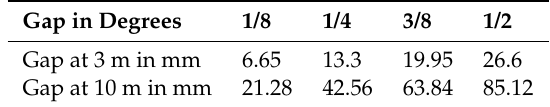
Figure 10. Angular resolution summary results: mean range using 10,000 sample sweeps stepping up to a gap of 1/2 ◦ . Table 4. Gap distance in millimeters as the angular distance increases from zero to 1/2 degrees in 1/8 degree